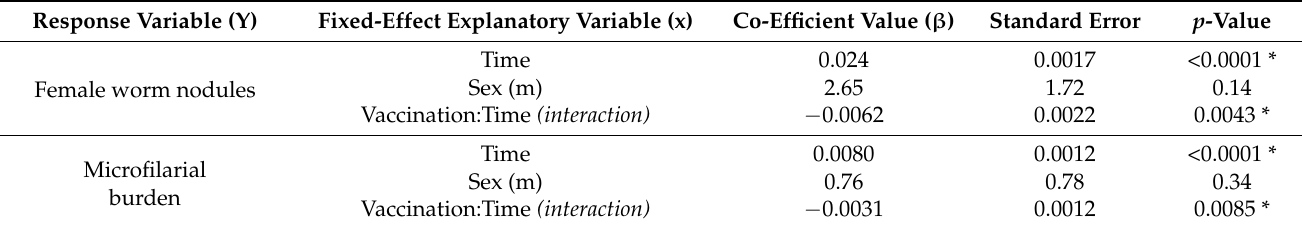
Table 3. Multivariable linear mixed effects regression analysis results for O. ochengi infection kinetics in vaccine efficacy trial calves over exposure period